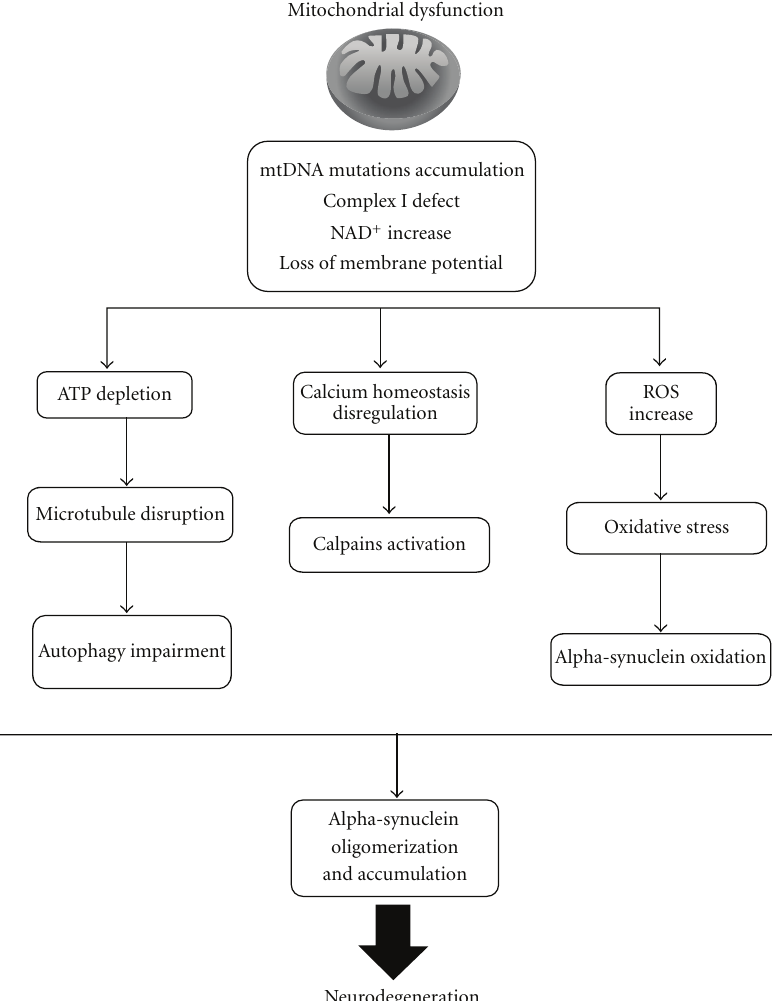
Figure 1: The mitochondrial cascade hypothesis for PD states that the inherited electron transport chain gene combinationsdetermine basal ETC e ffi ciency and ROS production. This defines the rate at which acquired mtDNA alterations occur determining when mitochondrial impairment reaches a threshold that activates the pathologic characteristics of PD. Mitochondrial impairment in PD is characterized by a complex I defect, which leads to ATP depletion and NAD + /NADH ratio imbalance promoting microtubule disruption. Moreover, mitochondrial membrane potential is lost and calcium homeostasis is deregulated, which leads to calpains activation. In addition, the levels of mitochondrial ROS are significantly increased triggering oxidative stress. These all prompt alpha-syn oligomerizationeither by interaction with free tubulin, calpains or by oxidation. The end result is alpha-syn oligomerization and accumulation of alpha-syn oligomers as well as of disrupted organelles culminating in